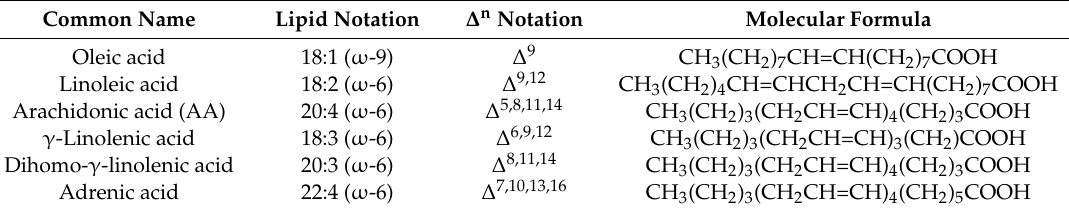
Table 1. Some representative unsaturated and polyunsaturated ω -6 fatty acids.